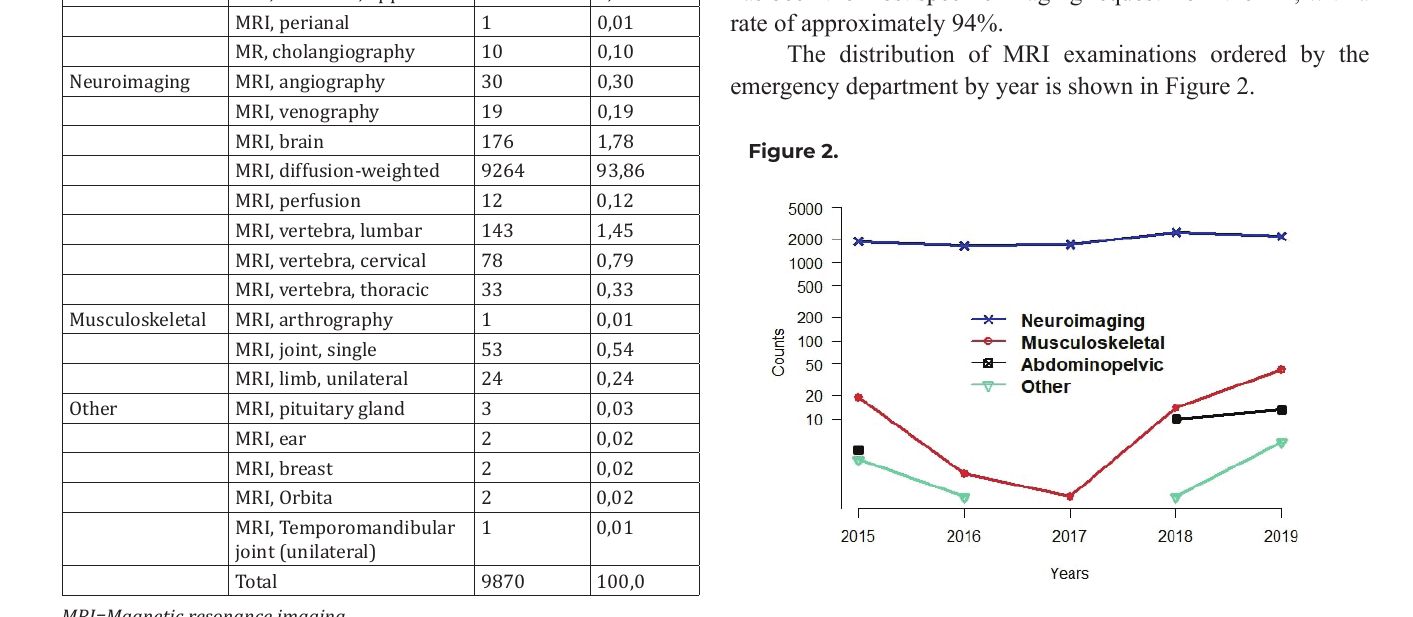
Evaluation of ED-ordered MRI examinations in terms of age, gender, working and out of hours, the weekend effect, order and shooting time difference, and hospitalization